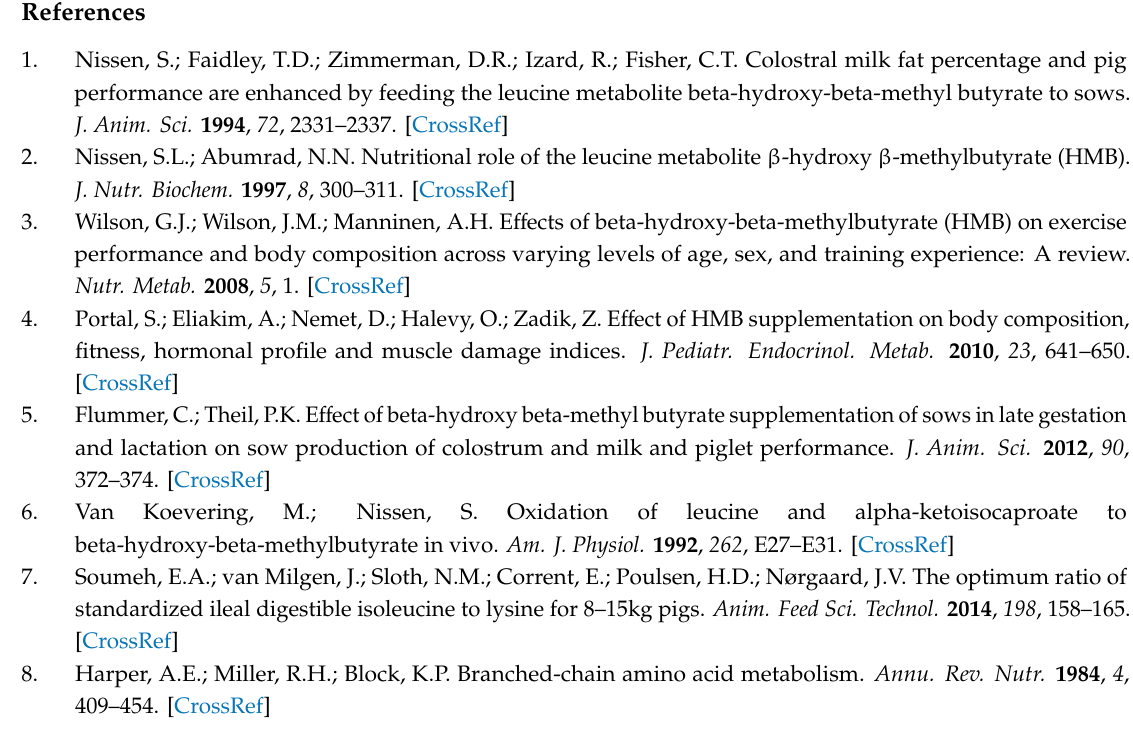
Table S1: Dietary ingredients and chemical composition of the control